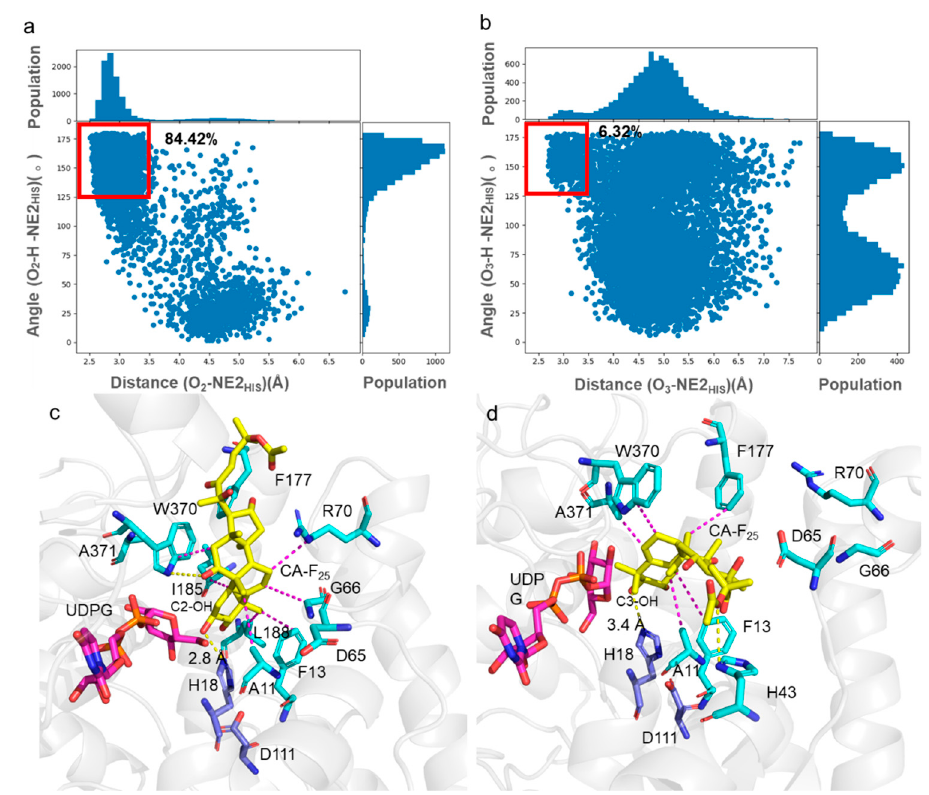
Figure 4. Conformation maps ( a , b ) and representative conformations ( c , d ) of (GT-SM)-(UDP-Glc)- (CA-F 25 ) complex in molecular dynamics (MD) simulation. CA-F 25 and UDP-Glc are shown as yellow and magenta sticks, respectively. Amino acids around CA-F 25 are shown as cyan sticks, and catalysis sites are in blue sticks. Yellow dotted lines indicate the hydrogen bonds. Hydrophobic interactions are shown as magenta dashes.